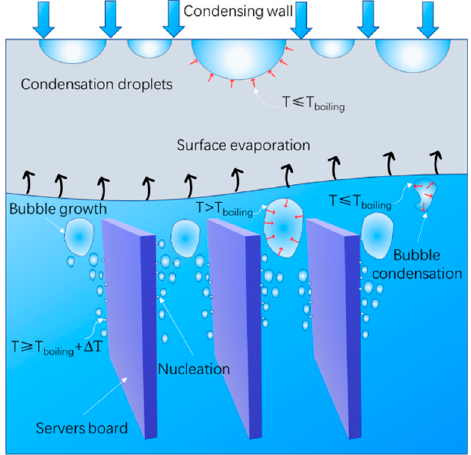
Figure 9. Schematic view of the heat transfer behavior during the boiling process.